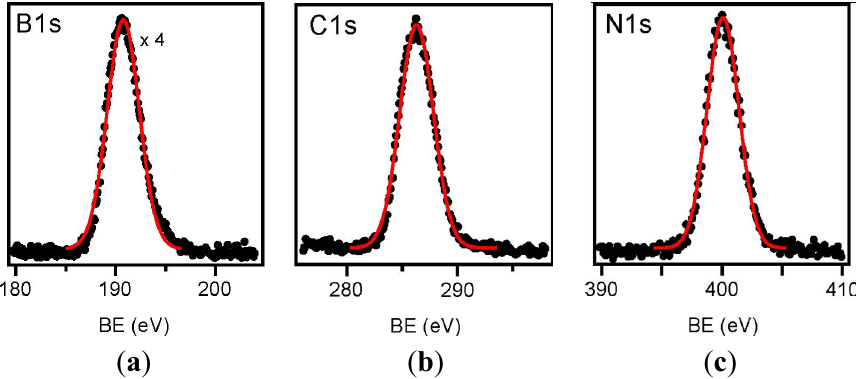
Figure 1. X-ray photoelectron spectroscopy (XPS) spectra of the ( a ) B 1s, ( b ) C 1s and ( c ) N 1s core levels of the pure